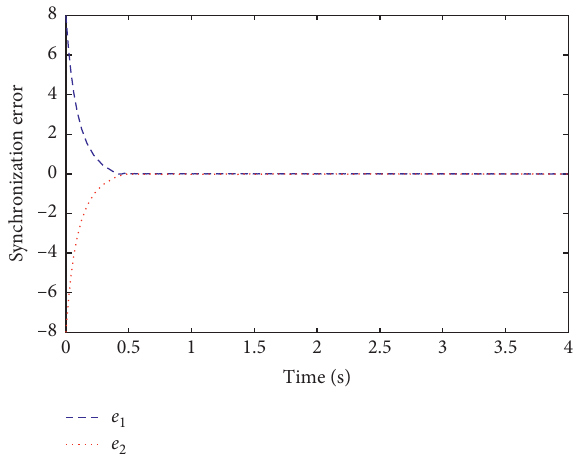
Figure 2: Predefined-time stability based on the controller (52) with time T c � 1.